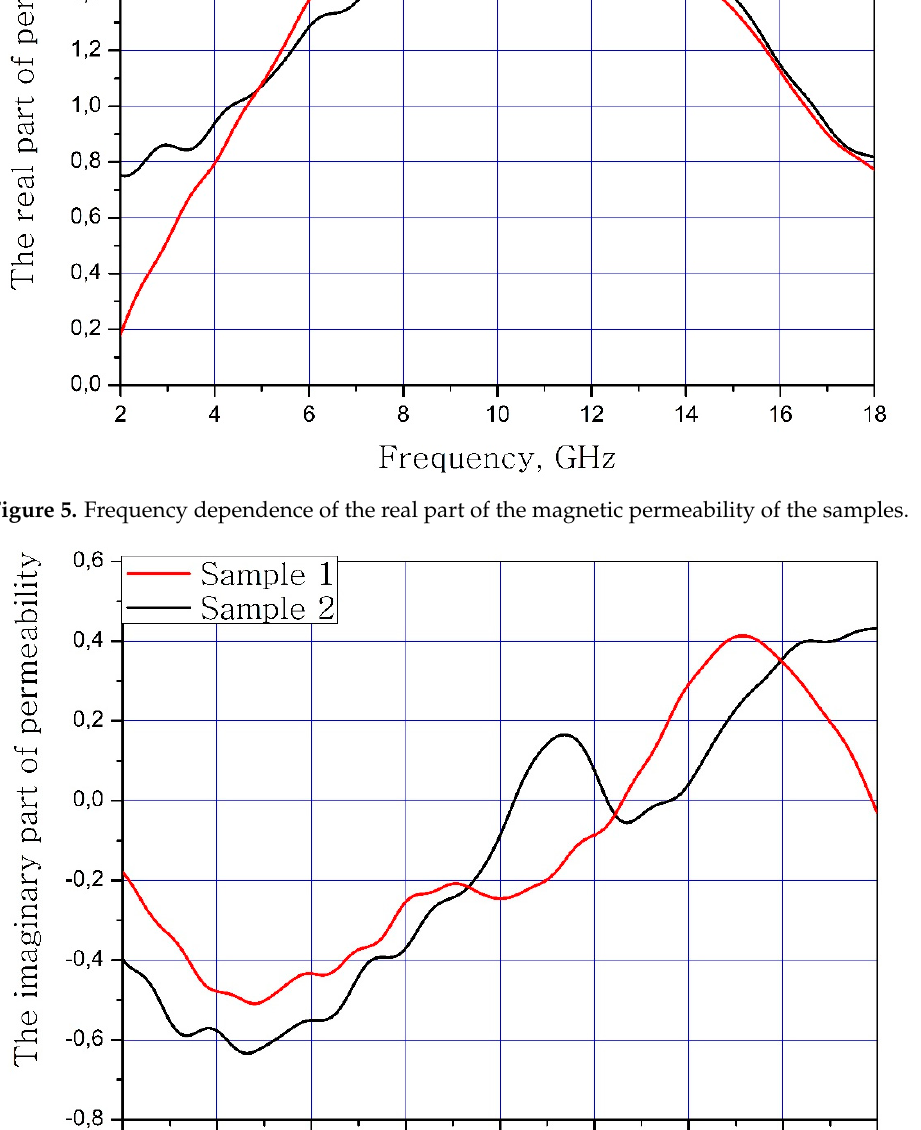
Figure 6. Frequency dependence of the imaginary part of magnetic permeability of samples.